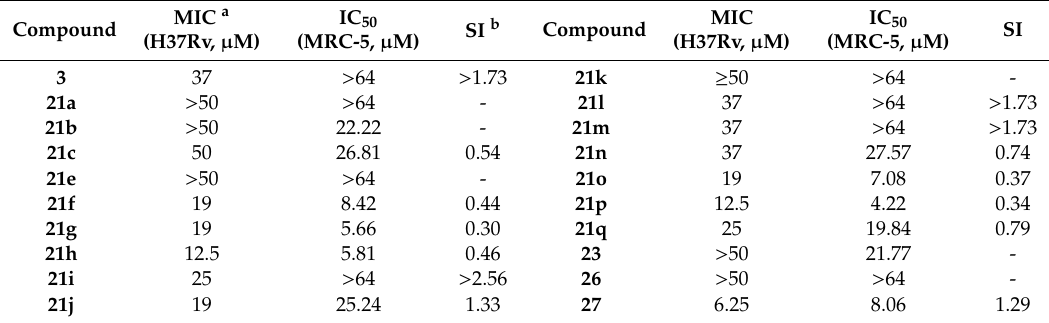
Table 3. Antimycobacterial activity against H37Rv and cytotoxicity against MRC-5 fibroblasts of the compounds in this study.